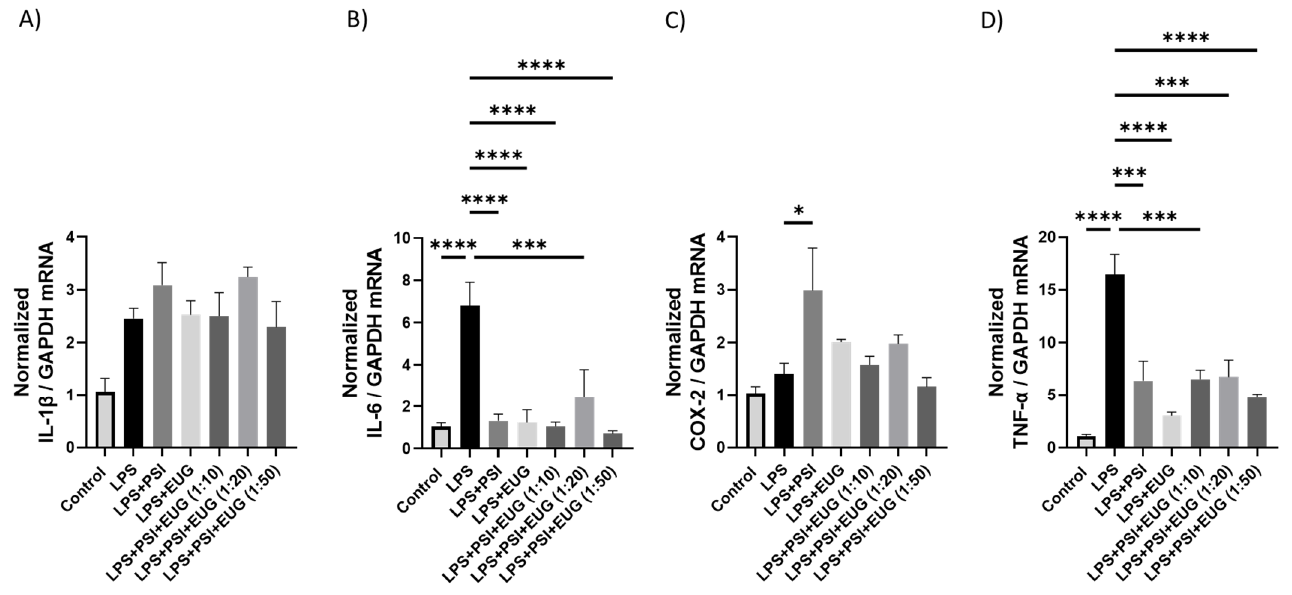
Figure 5. The effect of post-treatment on mRNA expression in brain tissue. Changes in mRNA expression as measured by RT-qPCR for: ( A ) IL-1 β , ( B ) IL-6 , ( C ) COX2 , ( D ) TNF- α . Glyceraldehyde-3- phosphate dehydrogenase ( GAPDH ) was used as a housekeeping gene. Data were analyzed with ANOVA and Dunnett’s post hoc test compared to LPS ( n = 3–6). Significance ( p ) is indicated within the figures using the following scale: *, p < 0.05; ***, p < 0.001; ****, p < 0.0001. Bars represent mean ± SEM.